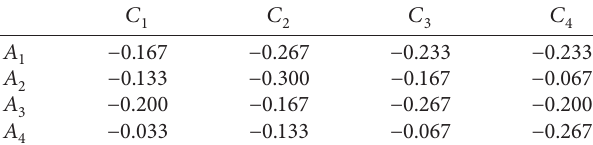
Table 3: Solution matrix based on the score